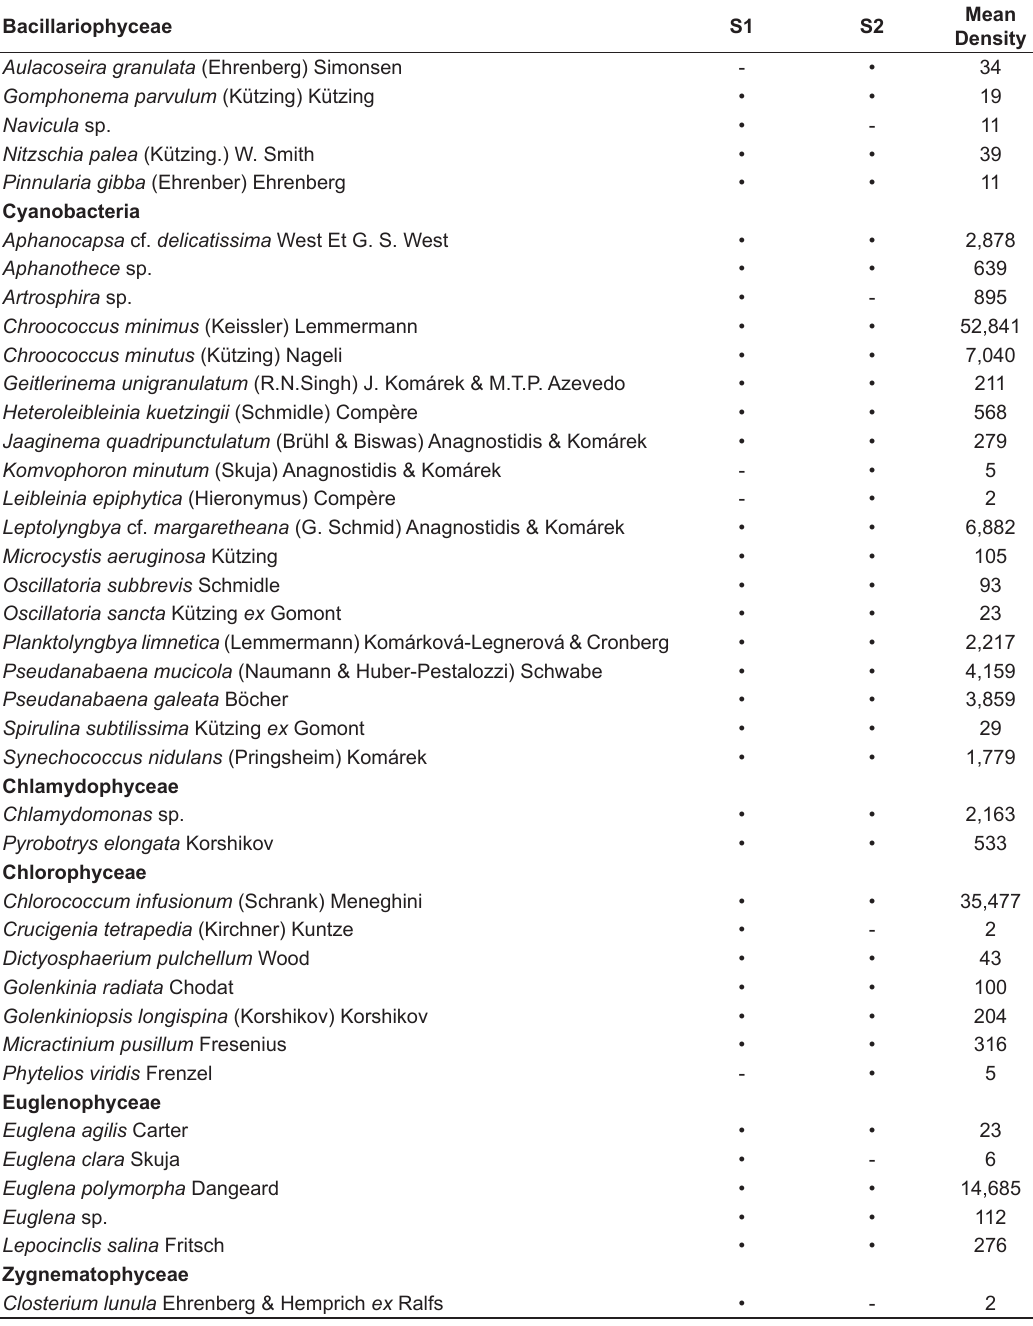
Table 2. Phytoplankton taxa recorded in the stabilization ponds (S1 – station 1; S2 – station 2) among March 2011 to February 2012 and mean density for each taxon (ind mL –1